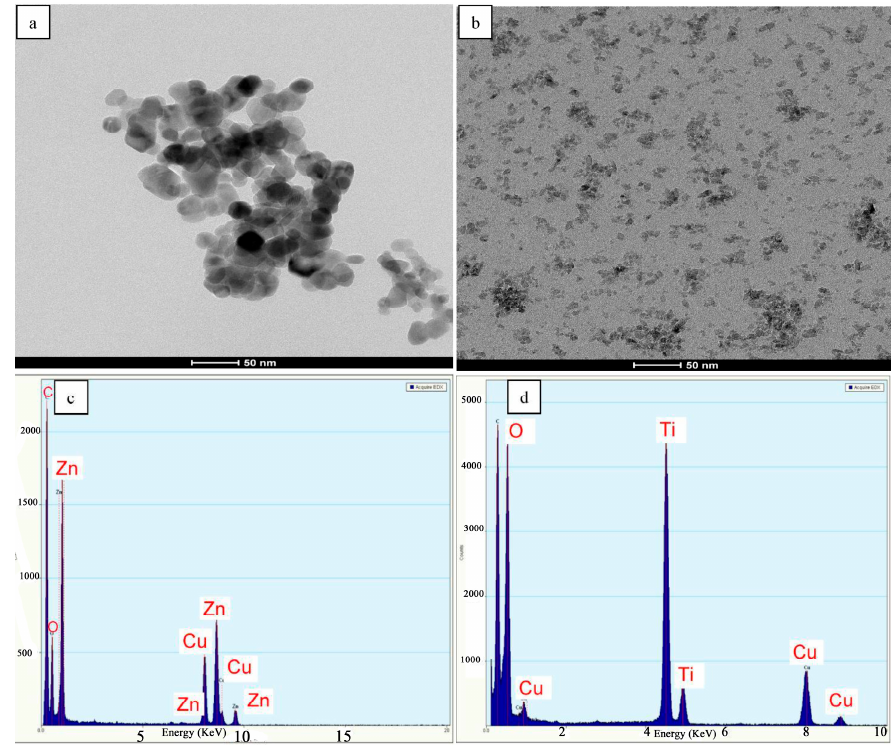
Figure 3. High-resolution transmission electron microscopy (HR-TEM) images of ZnO ( a ) and TiO 2 ( b ) nanoparticles, ( c ) EDX analysis of ZnO and ( d ) EDX analysis of TiO 2 .